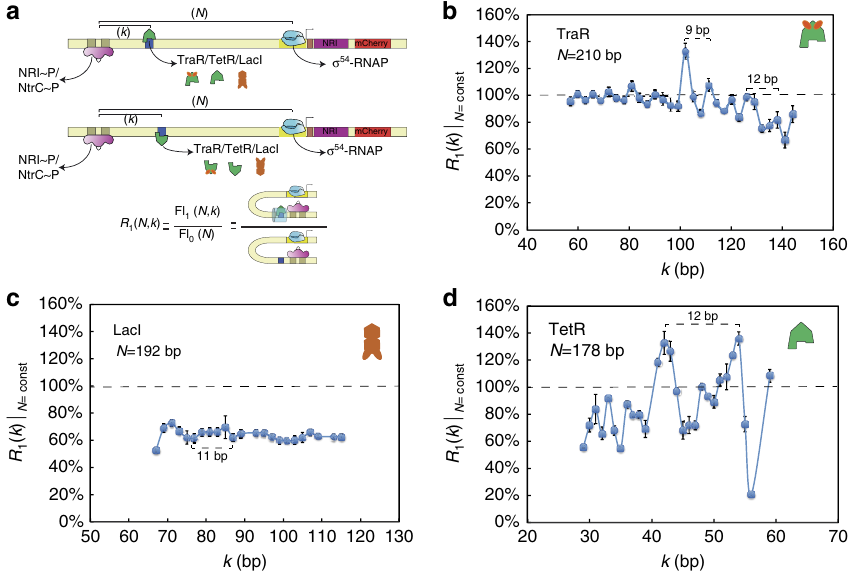
Figure 2 | Synthetic enhancers with a single TF-binding site. ( a ) Schematic for the minimal bacterial enhancer system used in our experiments, showing the poised holoenzyme complex at the s 54 promoter, NtrC activator and the additional binding site for either TraR, TetR or LacI. The schemas represent the two ‘extreme’ configurations. Top: binding sites are positioned ‘out-of-phase’ relative to the activator. Bottom: binding sites are positioned ‘in-phase’ relative to the activator. The schematic for TraR is drawn with two ovals corresponding to the 3OC8 ligand. ( b – d ) Expression level ratio results for synthetic enhancers with a single binding site for TraR ( b ), LacI ( c ) and TetR ( d ) at constant N . k was varied in 3, 2 and 1bp steps for TraR, LacI and TetR, respectively. In addition, we show in Supplementary Note 3 that the expression-level ratio observable as defined here is approximately equal to the probability-of-looping ratio given known rates for the NtrC- s 54 system, thus allowing us to quantitatively compare experimental results to theoretical predictions. Error bars correspond to the s.d. from multiple